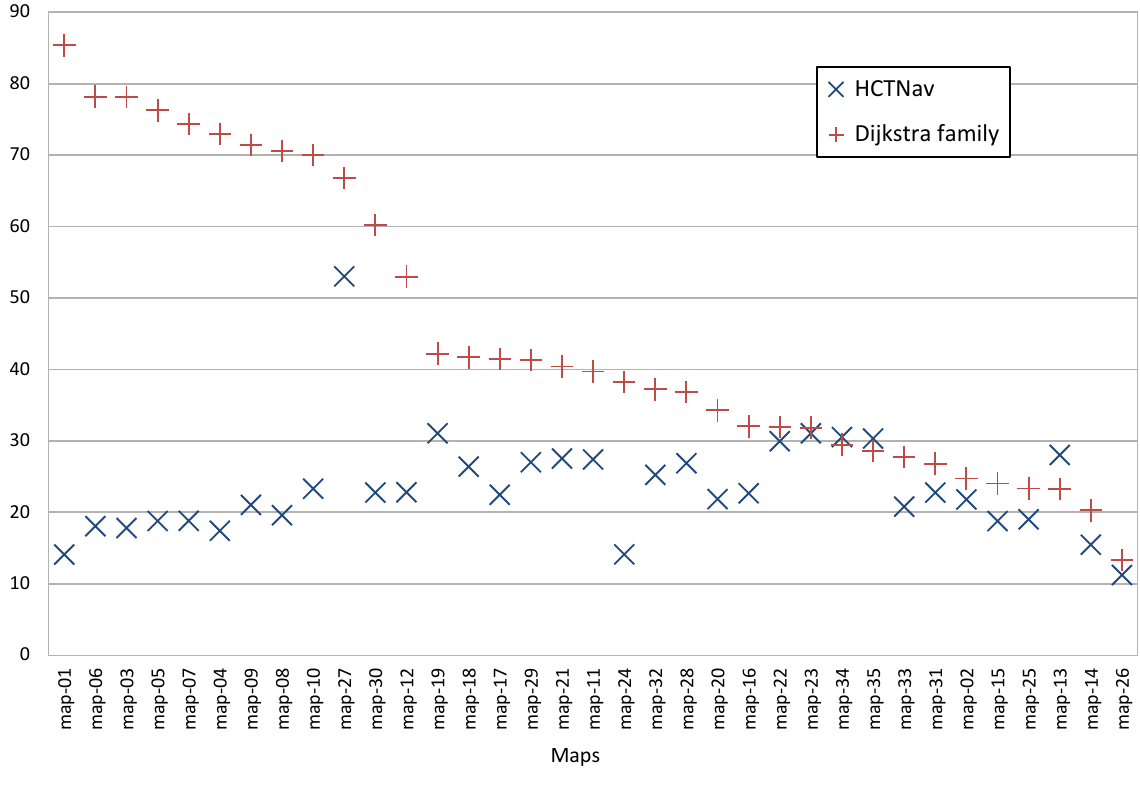
Figure 8. Comparing the dynamic memory “peaks” ( HCTNav vs . Dijkstra family). Maps have been ordered considering the result provided by the Dijkstra